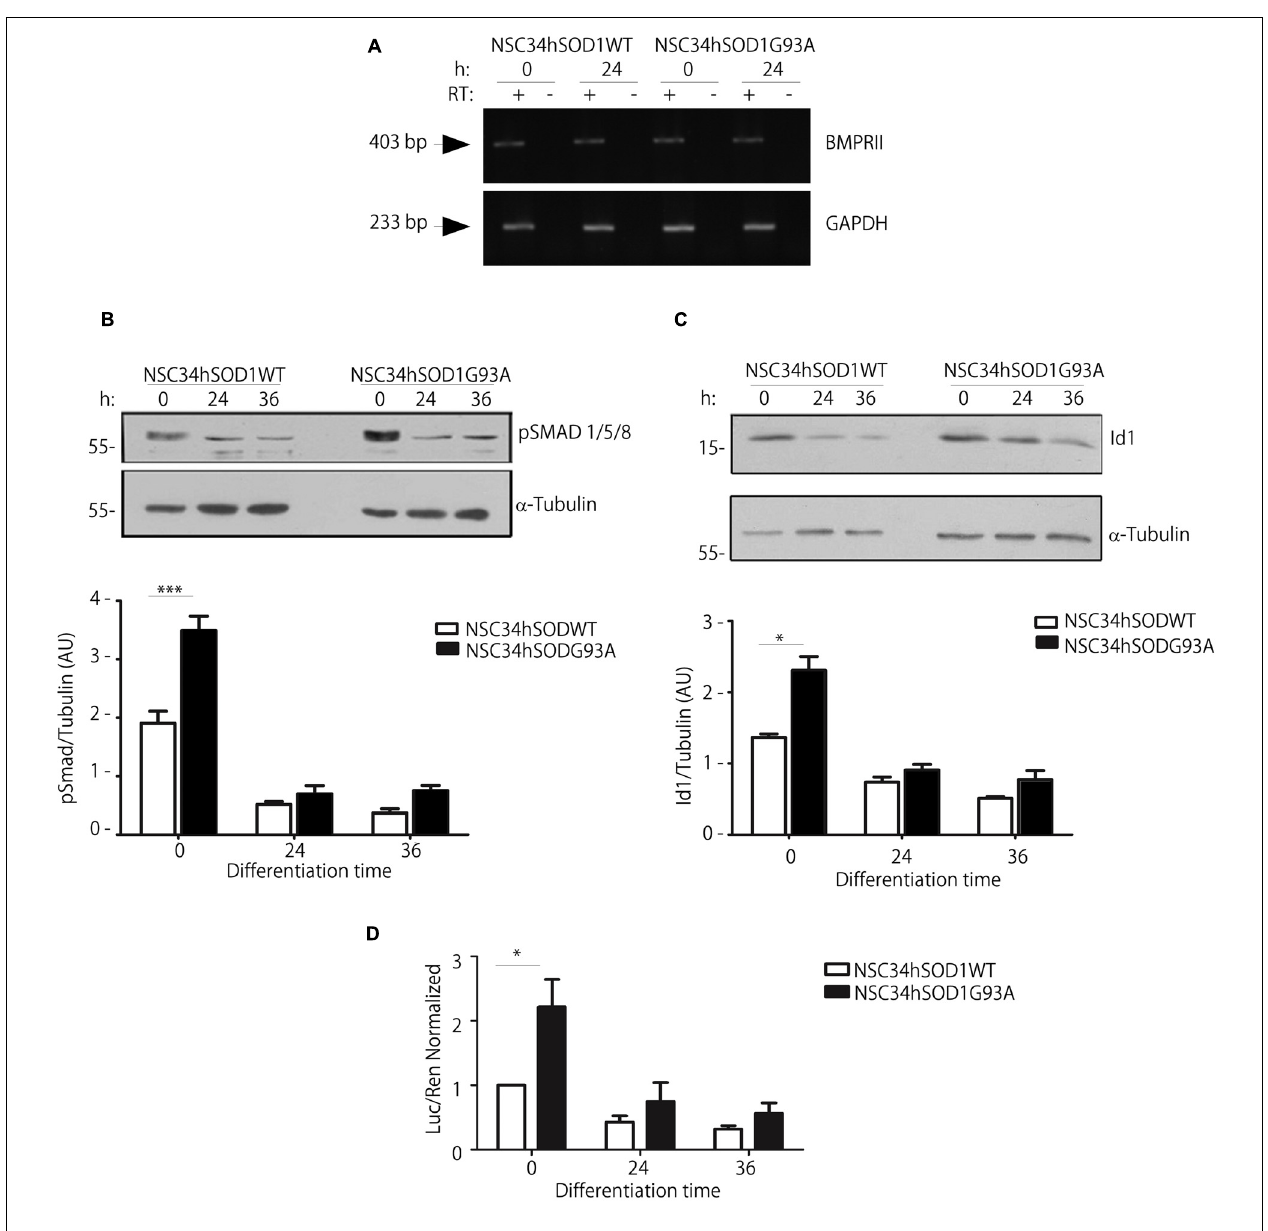
FIGURE 7 | Undifferentiated NSC34hSOD1G93A cells display increased activity of the BMP/Smad signaling pathway. (A) Total RNA was obtained from NSC34hSOD1 cells at 0 and 24 h of differentiation and BMPRII mRNA levels were analyzed by RT-PCR. As loading control GAPDH was amplified. Negative control reactions without reverse transcriptase (RT − ) are also shown. (B,C) Western blot analysis using anti pSmad (B) or anti Id1 (C) antibodies in protein extracts of NSC34hSOD1 cells obtained at the indicated times